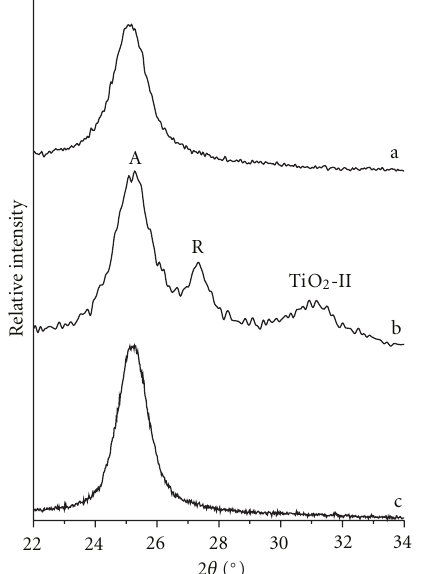
Figure 2: XRD diagrams of the starting TiO 2 sample—TIT 144 (a) and the samplesground for 1.6 hours withoutadditives (b) and with ammonium carbamate—TIT 144 ground (c),